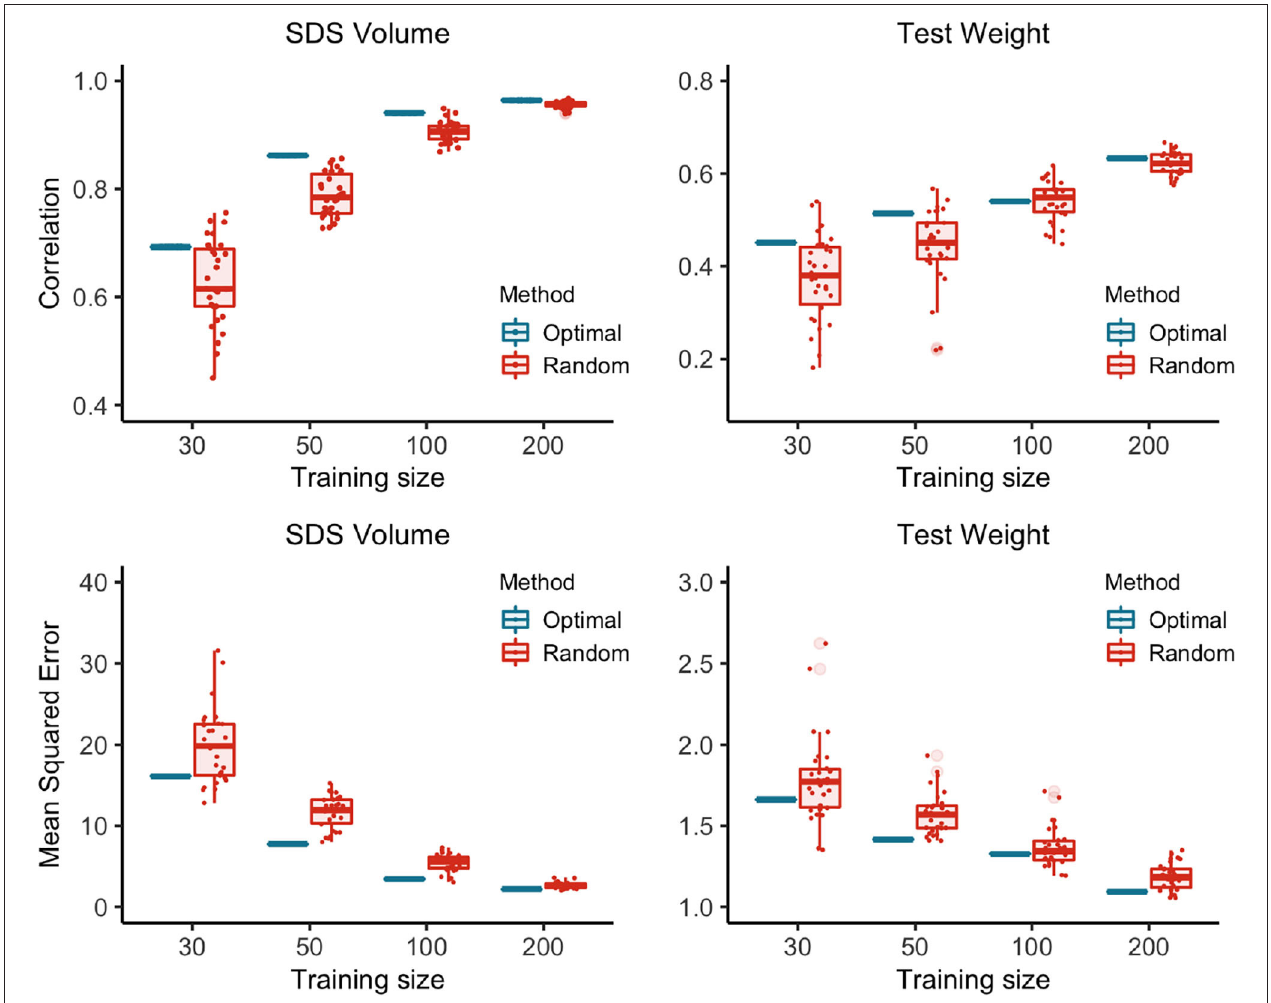
FIGURE 2 | The correlations and the mean squared errors between the predicted and observed trait values of the hybrids in the test data. There is an advantage in using optimized training samples for this dataset. The correlations and mean squared errors between the predicted and observed trait values of the hybrids in the test sets were significantly better for the optimized samples than the correlations and mean squared errors of the predicted and observed for the random